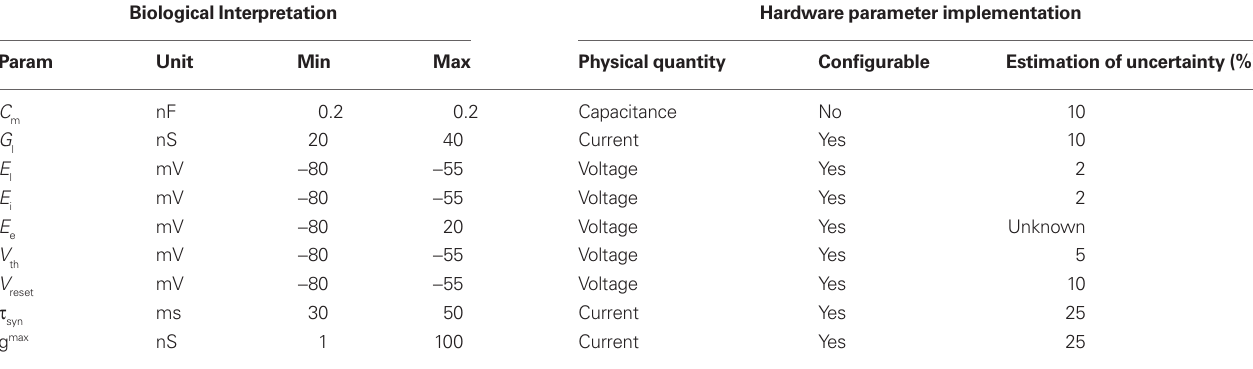
Table 1 | The most important hardware model parameters, the type of physical quantity used for their implementation, their confi gurability and an estimation of uncertainty. The fi rst four columns show their typical biological interpretation and the resulting value ranges. The translation between both domains depends on the chosen speedup and the desired biological parameter value ranges. The given estimations (some being educated guesses) of confi guration uncertainty refl ect the current state of available methods to measure, to adjust or to calibrate the values, and may not necessarily refl ect hardware limitations. The uncertainty of E is load-dependent, the relation is not yet suffi ciently e